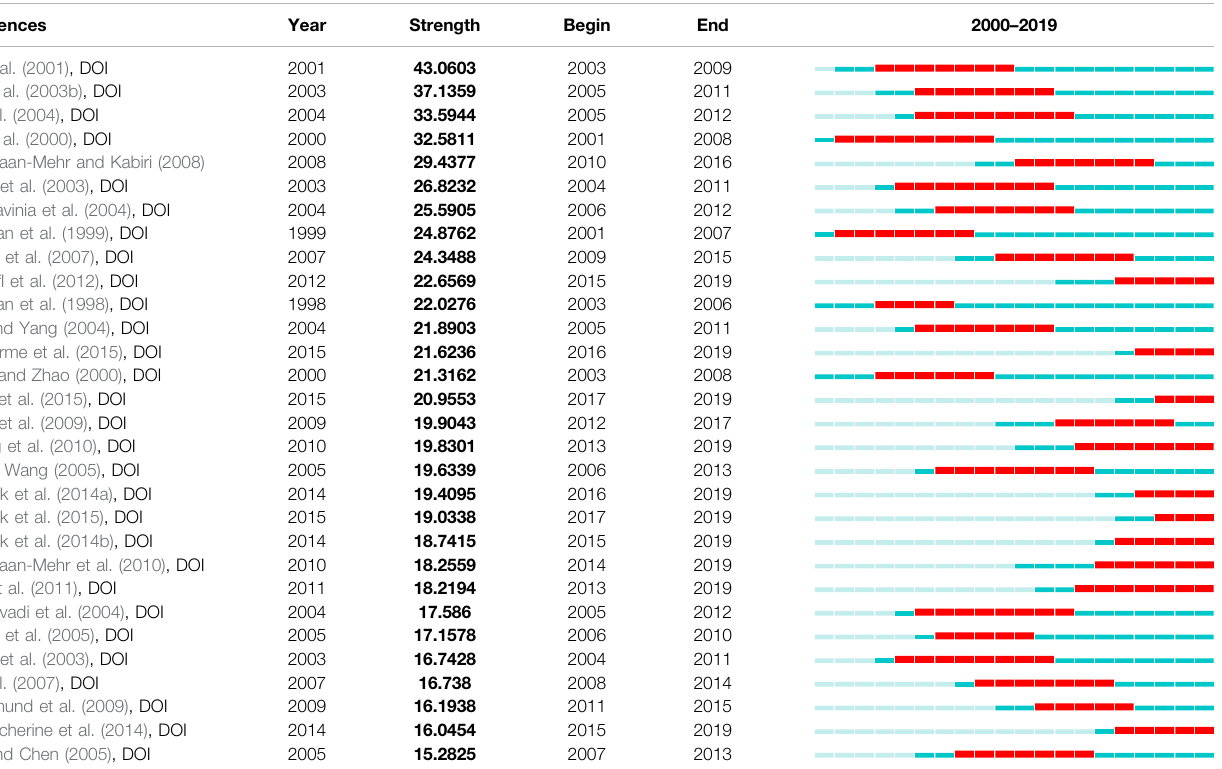
TABLE 4 | Top 30 strongest citation burst articles in SAPs (ranked by Strength value, in